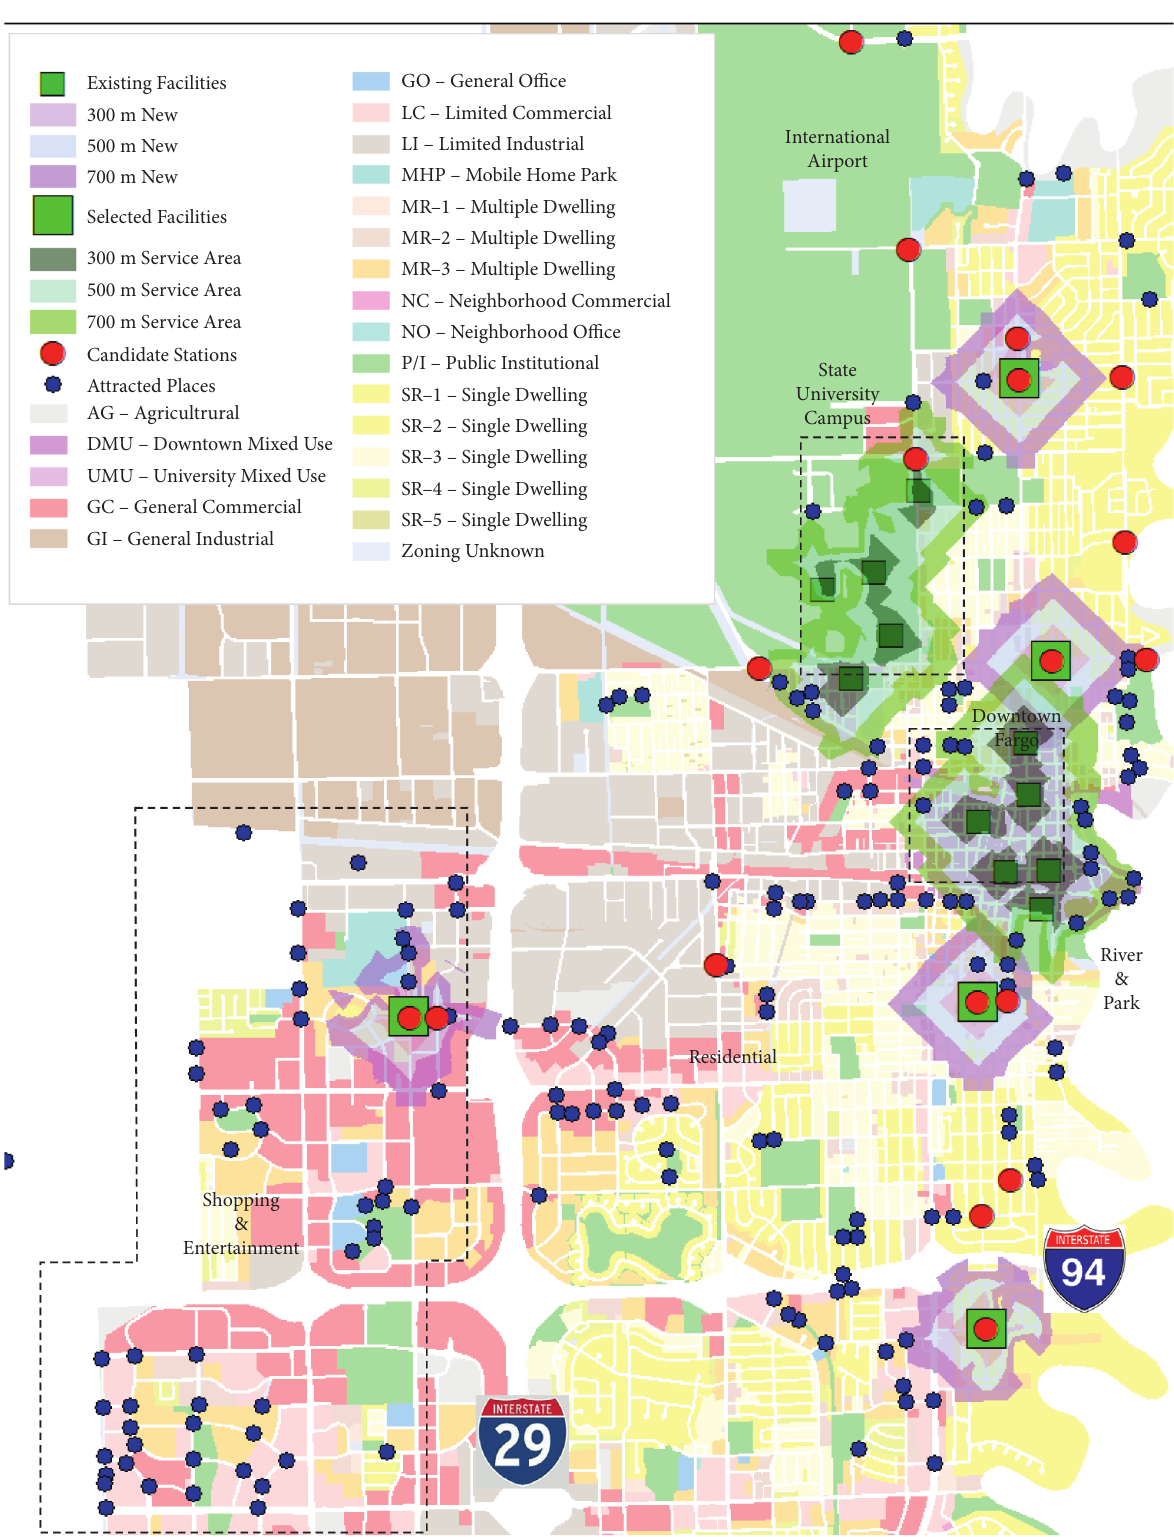
Figure 4: Selected facilities and new service areas relative to land-use zoning in the city of Fargo,